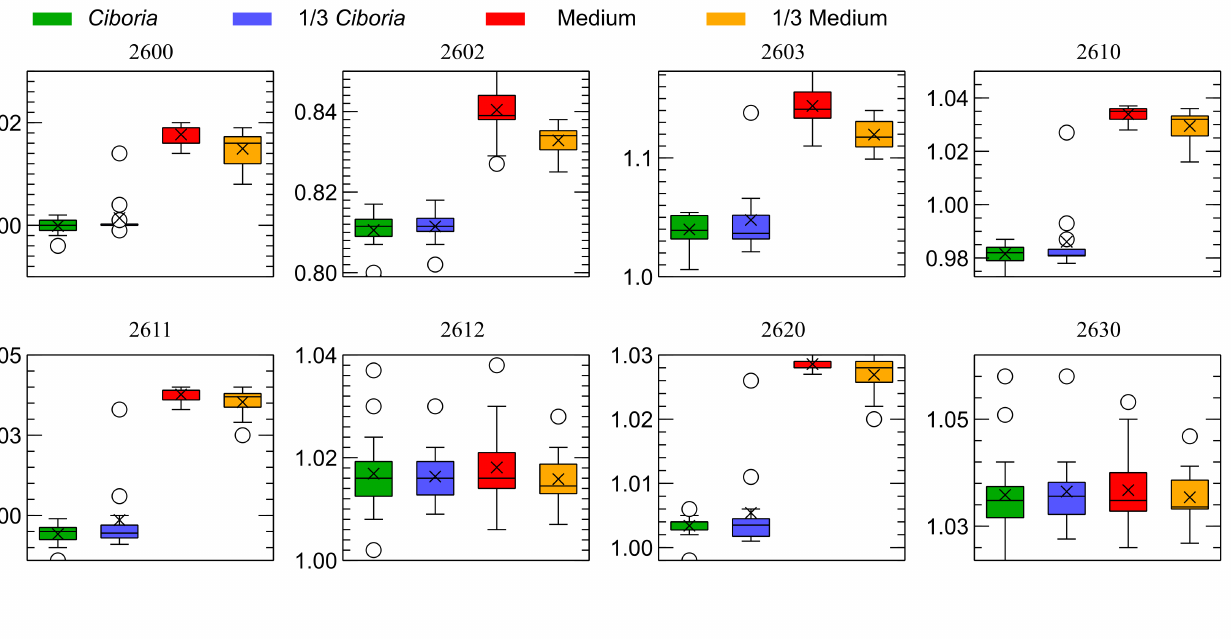
Figure 9. Distribution of the sensor response magnitude collected at the moment of 150 sensor reads from the beginning of the second observation stage (Figure 7). Comparison of four categories of samples used in the